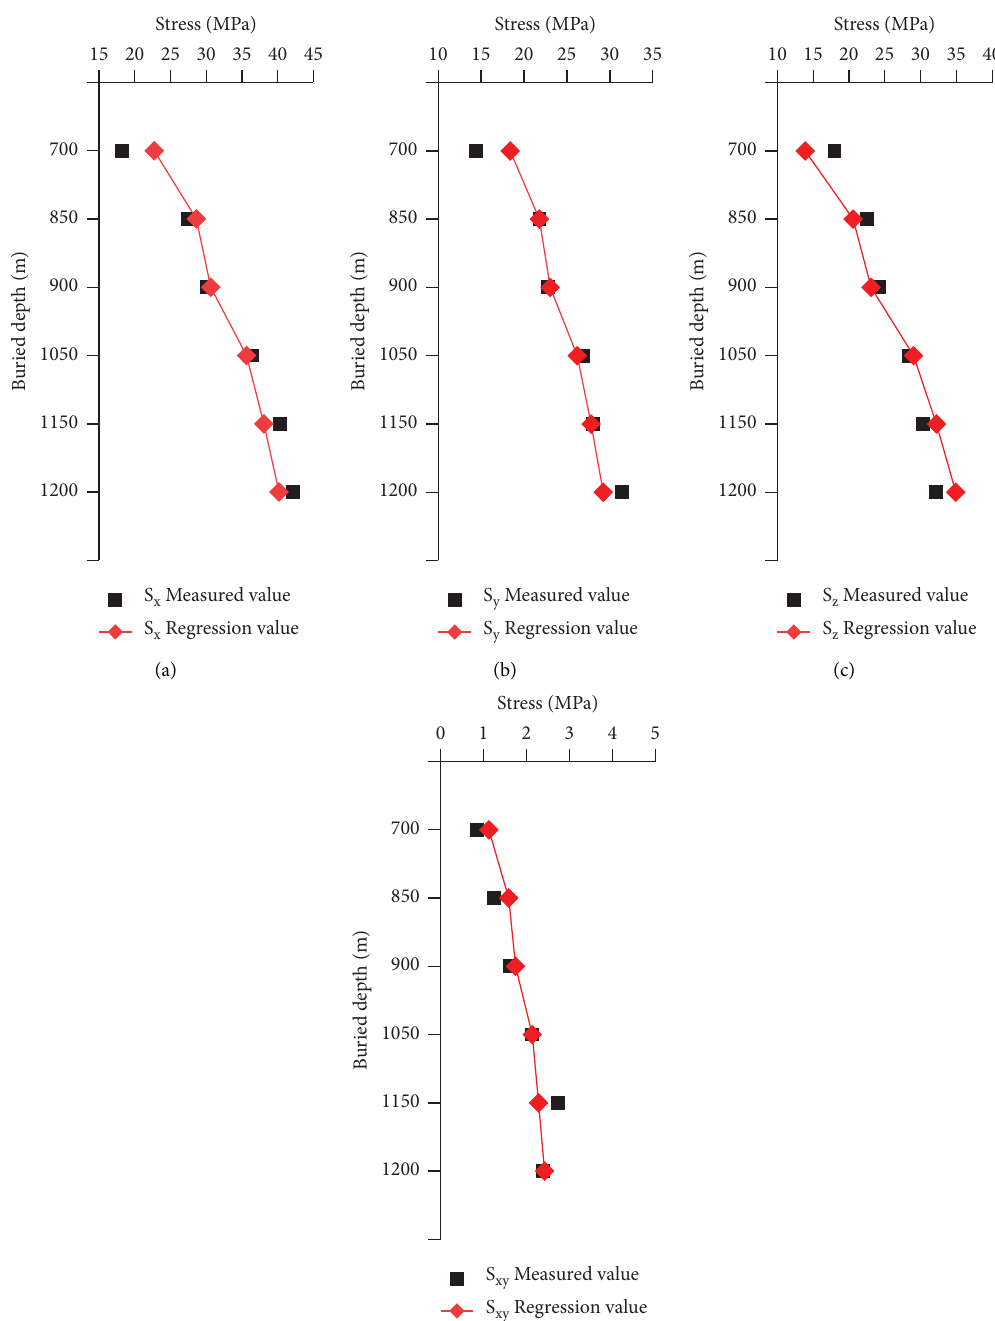
Figure 3: Comparison of measured tectonic stress component values and regression calculation values along the buried depth. (a) S (c) S z . (d) S xy